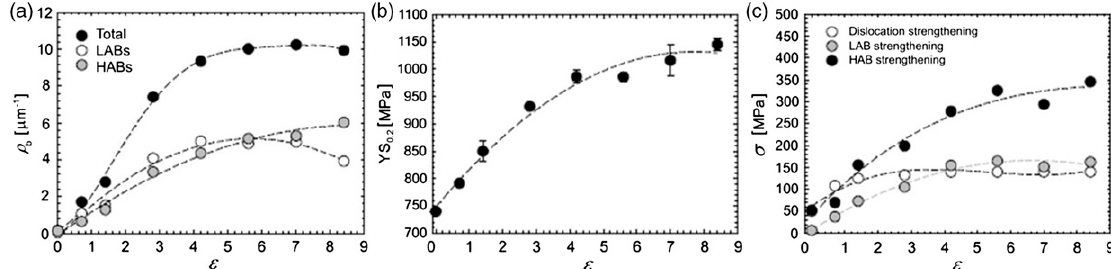
Figure 1. Influence of ECAP-C strain on ( a ) grain boundary (GB) density, ( b ) yield strength and ( c ) the contribution of various strengthening mechanisms [21].